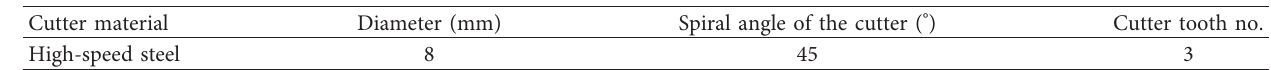
Figure 8: Vibration pattern diagram of the vibration device model. (a) 1 st order. (b) 6 th order. (c) 9 th order. (d) 16 th order. (e) 19 th order. (f) 30 th order. Table 3: Tool